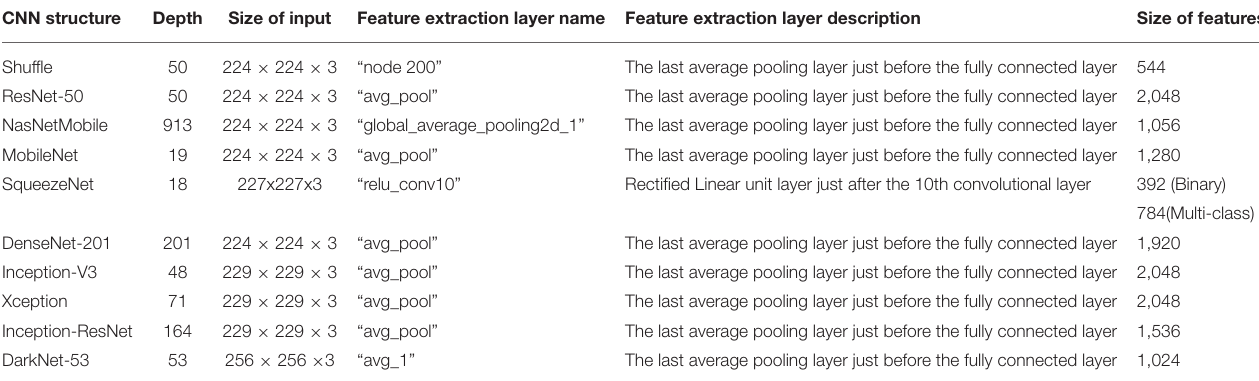
TABLE 1 | The depth, input, and output sizes of the 10 CNNs along with the description of the layers from which features where